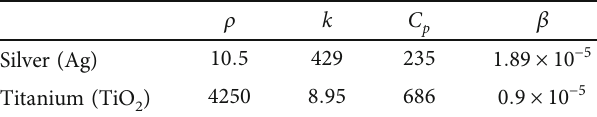
Table 7: Riahi et al. ’ s [38] thermophysical properties of silver titanium